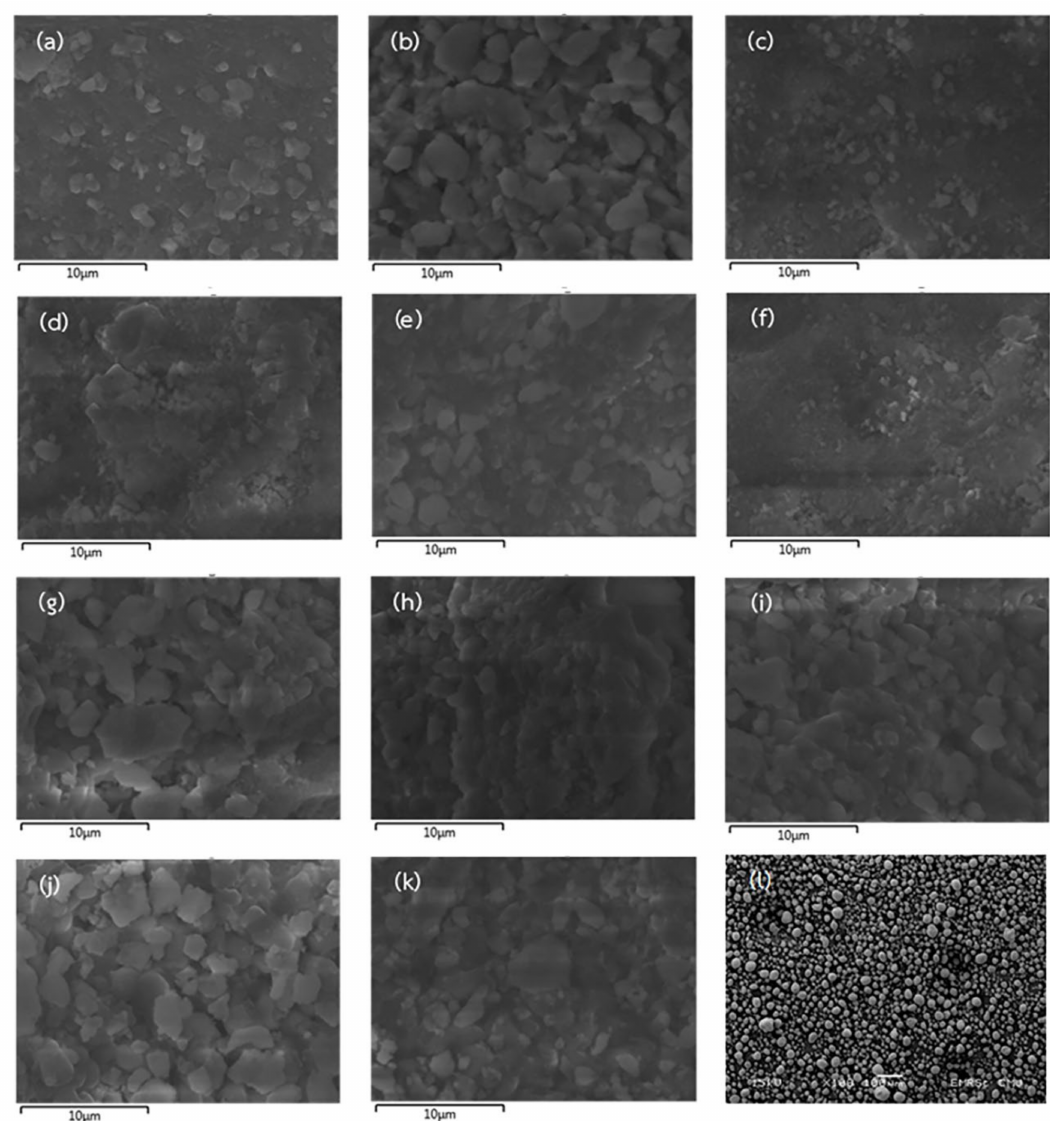
Figure 3. Microstructure from scanning electron microscopy (SEM) of hydroxyapatite obtained by using 2% HCl 10 min ( a ), 5% HCl 10 min ( b ), 2% HCl 60 min ( c ), 5% HCl 60 min ( d ), 2% HCl 35 min ( e ), 5% HCl 35 min ( f ), 3.5% HCl 10 min ( g ), 3.5% HCl 60 min ( h ), 3.5% HCl 35 min Rep.1 ( i ), 3.5% HCl 35 min Rep.2 ( j ), 3.5% HCl 35 min Rep.3 ( k ), and the commercial hydroxyapatite ( l